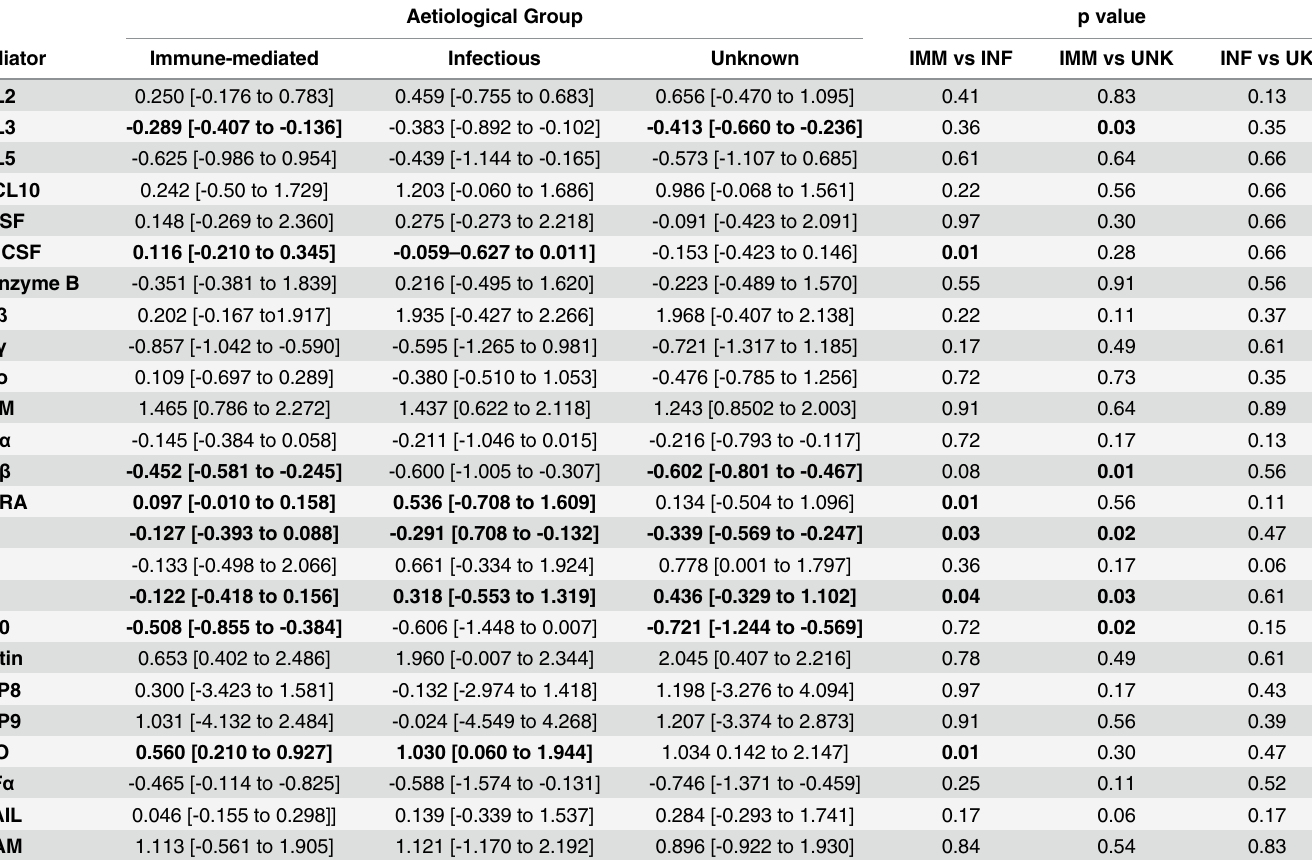
Table 4. Median concentrations of identified mediators between the aetiological groups of encephalitis in cerebrospinal